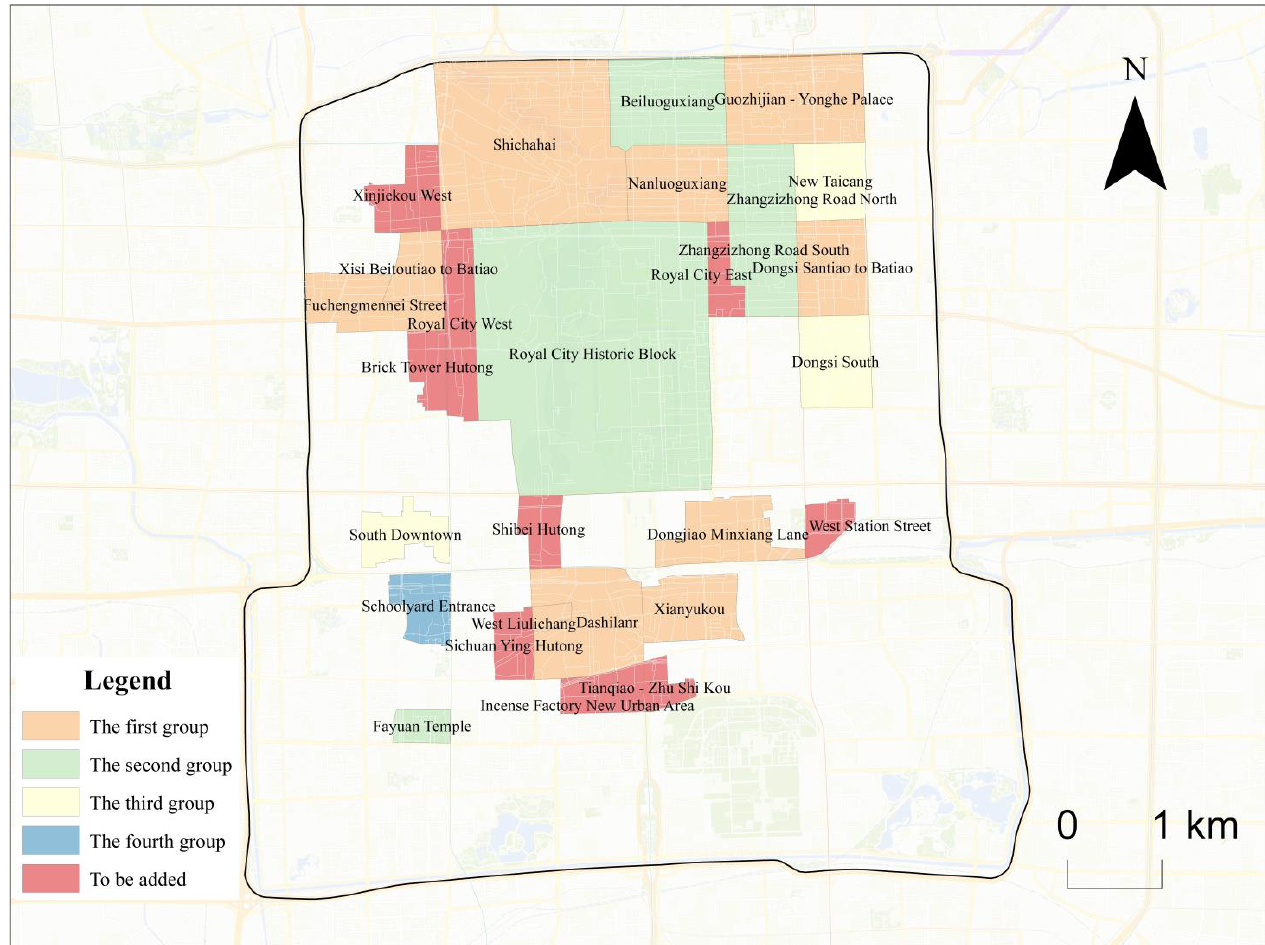
Figure 1. Spatial distribution of historic and cultural blocks.